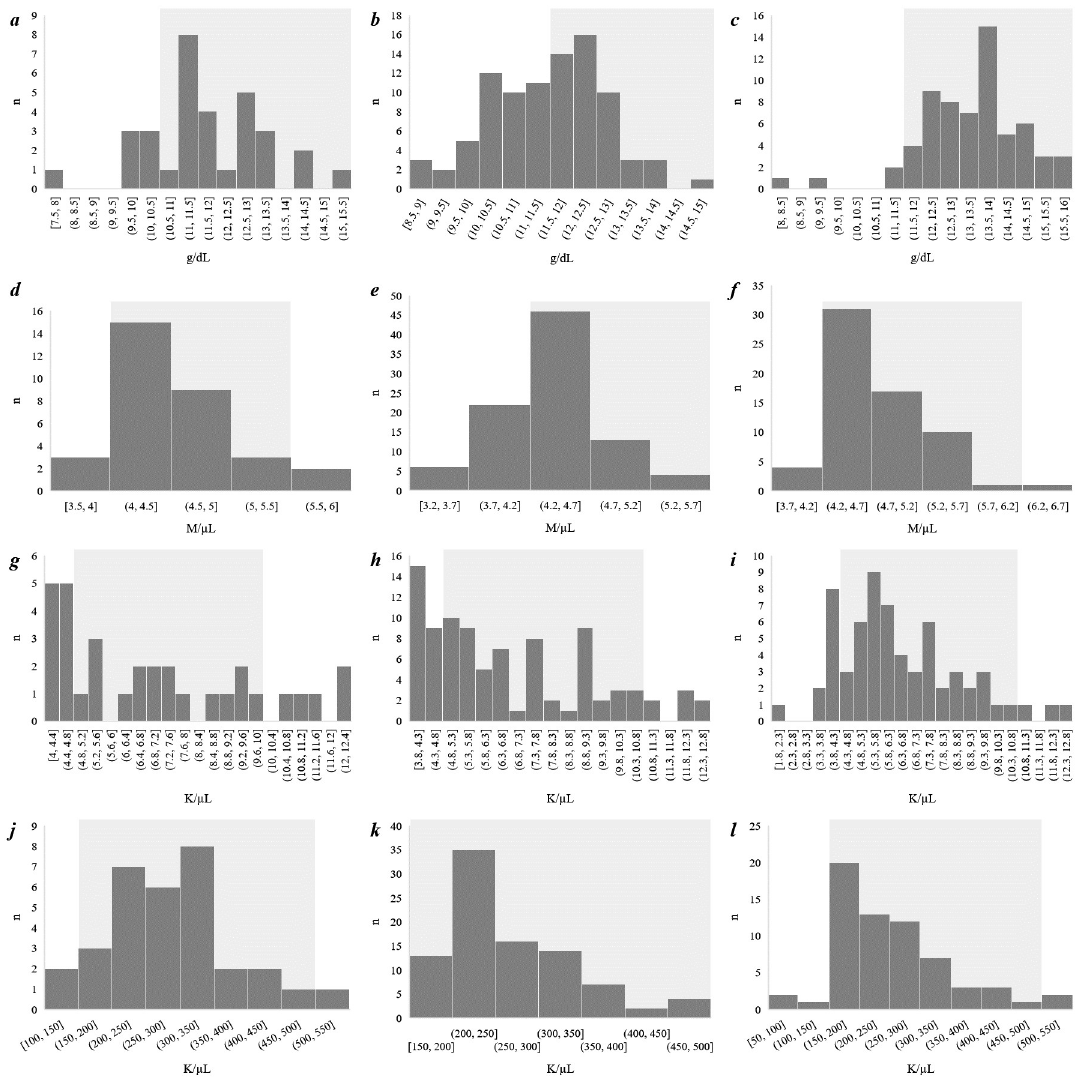
Fig 4. Histogram representing the major hematological findings from CHIKV positive patients. Shadowed area presents the reference ranges. a) Hemoglobin level in children. b) Hemoglobin levels in females. c) Hemoglobin level in males. d) RBC counts in children. e) RBC counts in females. f) RBC counts in males. g) WBC counts in children. h) WBC counts in females. i) WBC counts in males. j) Platelet counts in children. k) Platelet counts in females. l) Platelet counts in